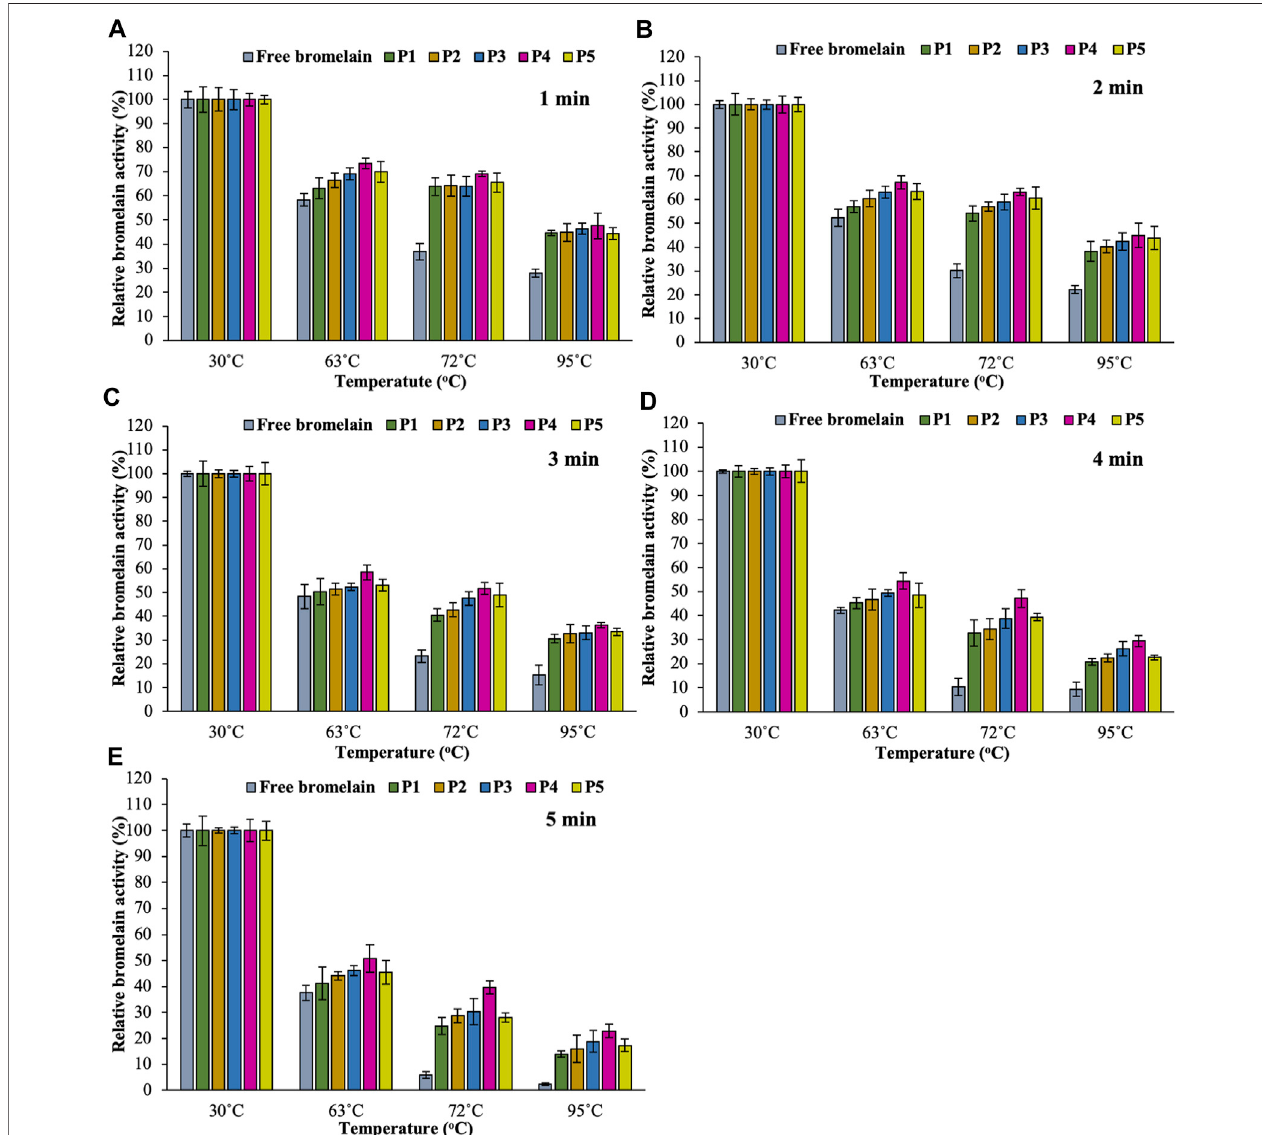
FIGURE 8 | Effect of temperature (in PBS at pH 7.4) on the activity of free bromelain and encapsulated bromelain (P1, P2, P3, P4, and P5) for 1 min (A) , 2 min (B) , 3 min (C) , 4 min (D), and 5 min (E) in an incubator with 100 rpm shaking.